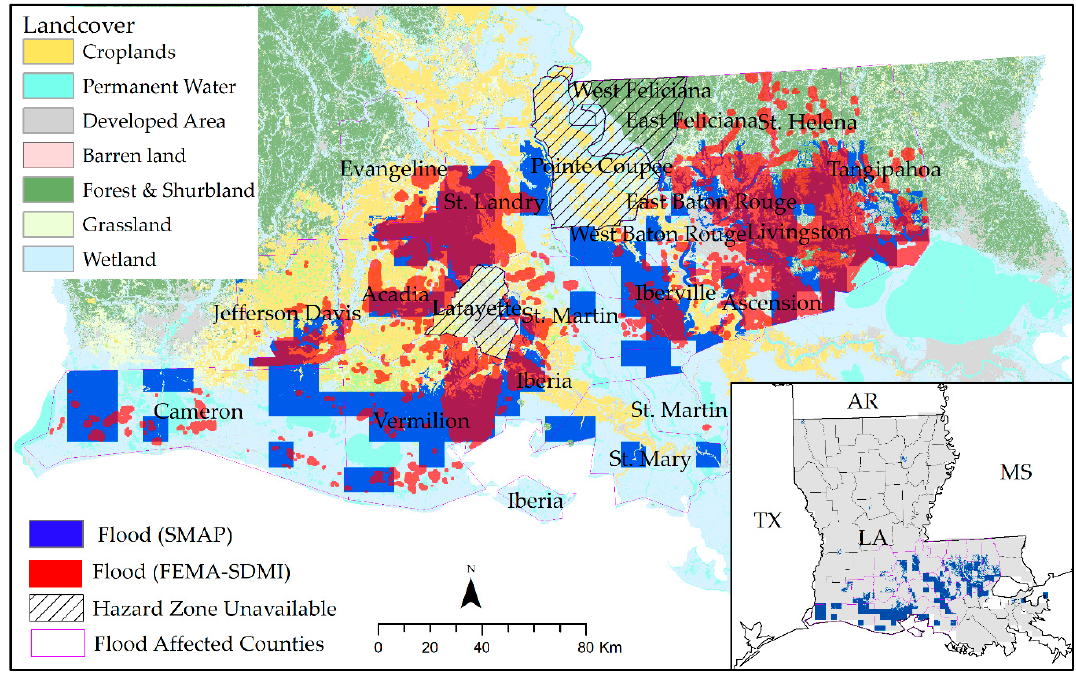
Figure 6. Inundation area extracted from SMAP and FEMA-SDMI of the Baton Rough Flood superimposed over CDL. superimposed over